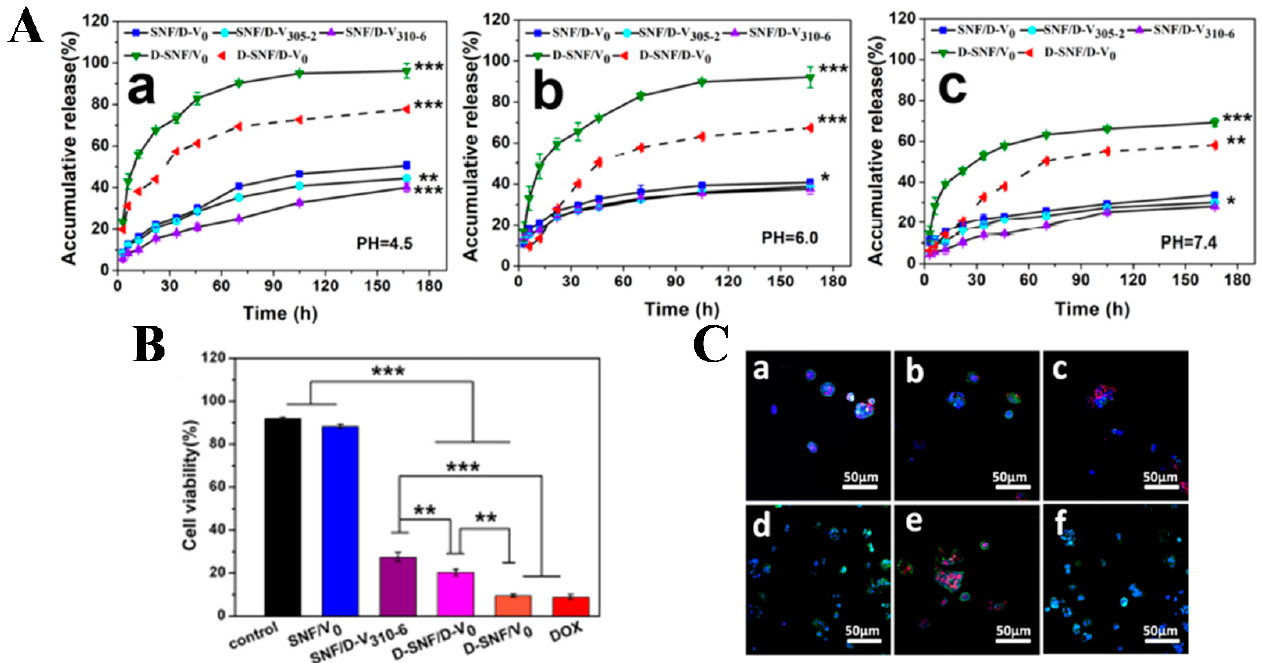
Figure 2. ( A ) pH-dependent release of DOX from the SNF/D-V 0 , SNF/D-V 305-2 , SNF/D-V 310-6 , DSNF/V 0 , and D-SNF/D-V 0 systems for 3 − 167 h at pH 4.5 ( a ), 6.0 ( b ), and 7.4 ( c ). Statistically signif- icant: * p < 0.05, ** p < 0.01, *** p < 0.001; ( B ) viability of human breast cancer cells (MCF-7) cultured